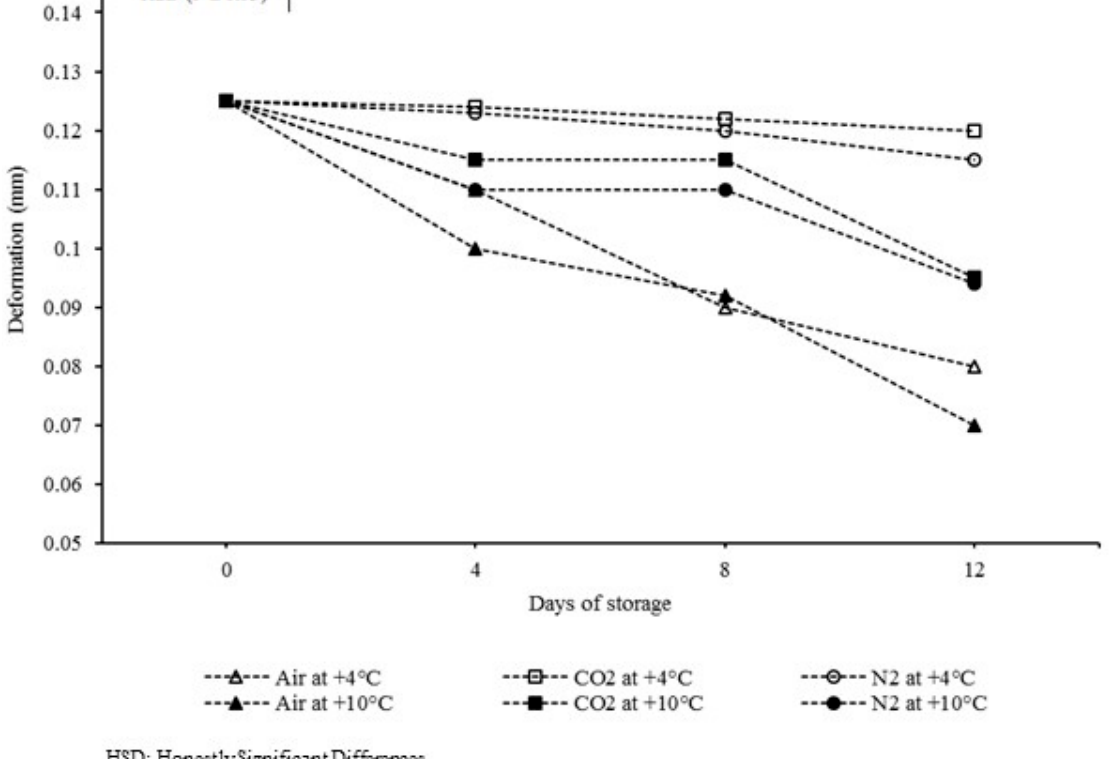
Figure 5. Deformation of almond kernels over 12 days of storage at +4 °C and +10 °C in air, 100 ± 1 kPa of CO 2 , and 100 ± 1 kPa of N 2 , respectively.